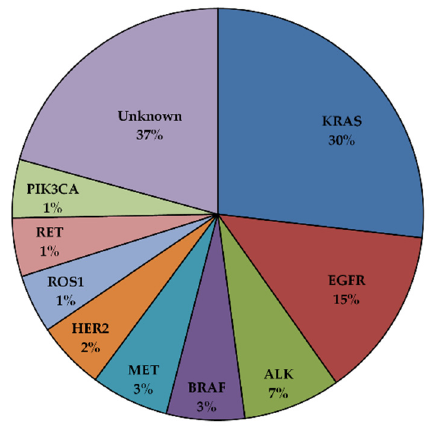
Figure 1. Driver oncogenic mutations in NSCLC [11,12]